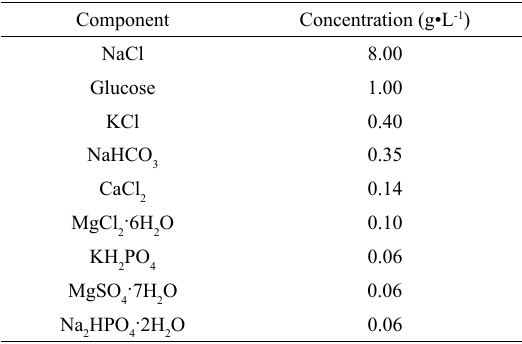
Table 1. Chemical components of Hank’s